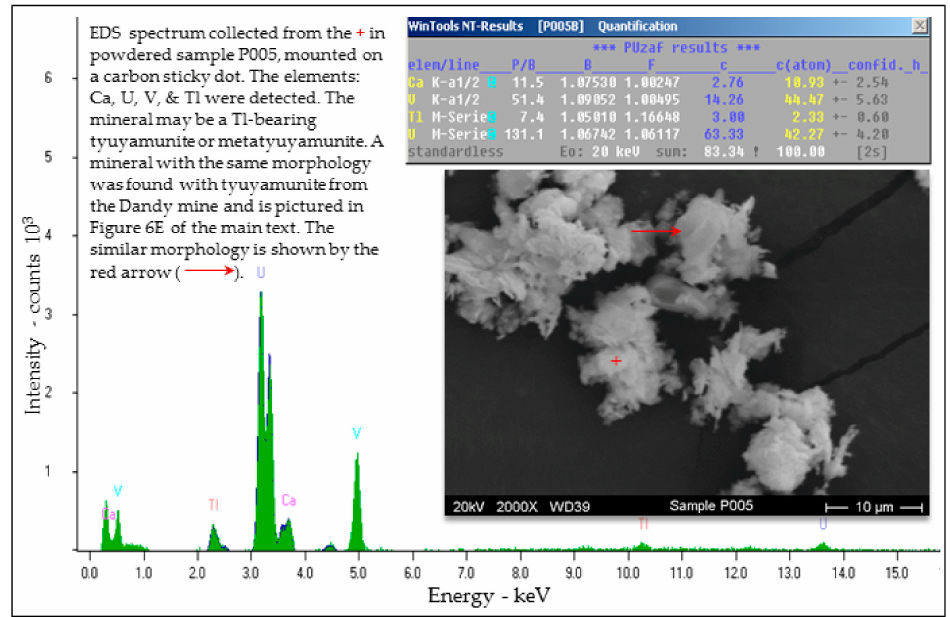
Figure A4. EDS spectrum for Tl-bearing uranyl vanadate from sample P005 collected from a U prospect in the PMD. The weight percent of the elements are similar to the carnotite group of metal-uranyl vanadates; the mineral may be a Tl-bearing variety. A mineral with the same morphology was found with tyuyamunite in a sample from the Dandy mine (Figure 9 main document). This sample had 340 ppm Tl (Table A1). Tl and Pb have similar atomic and covalent radii: Tl (1.70 Å and 1.47 Å) and Pb (1.75 Å and 1.46 ± 5 Å).